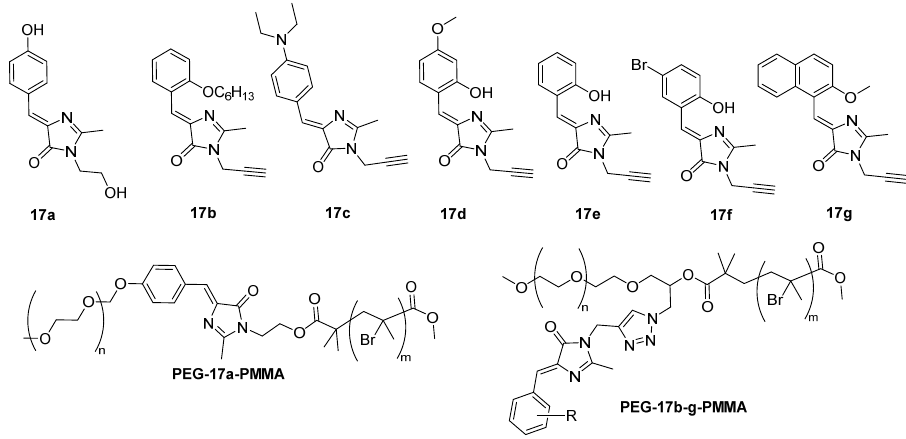
Figure 17. GFPc-copolymer with strong fluorescence after self-assembly into micelles [31,32].